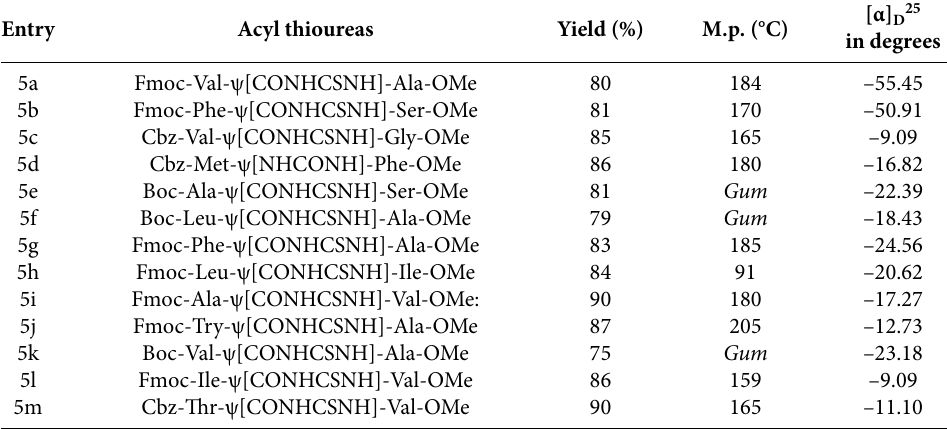
Table 1. List of N α -protected acyl thioureas synthesized via scheme 1 Entry Acyl